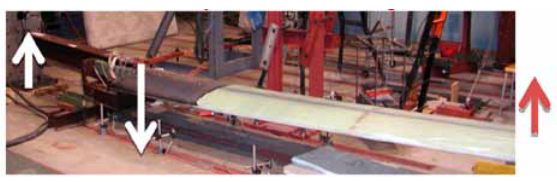
Fig. 1. Wing bend test